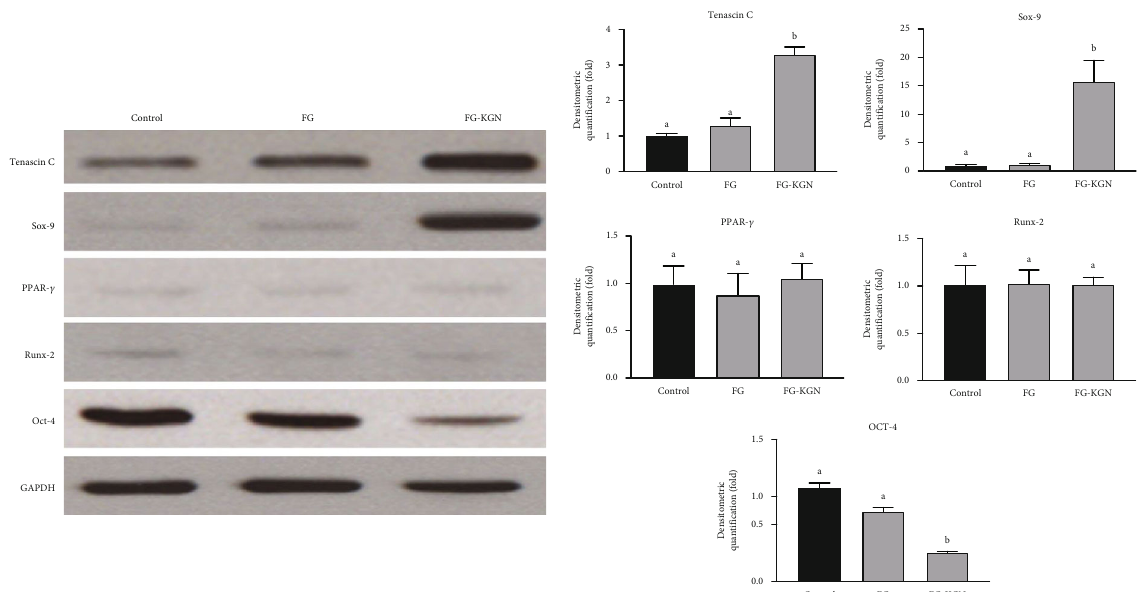
Figure 5: The western bolt results. There was non signi fi cant di ff erence in the expression of each protein between the FG group and the control group, while the expression of Tenascin C and Sox-9 in the FG-KGN group was signi fi cantly higher than that in the other two groups (P < 0.01). The expression level of OCT-4 in the FG-KGN group was lower than that in the other two groups (P <